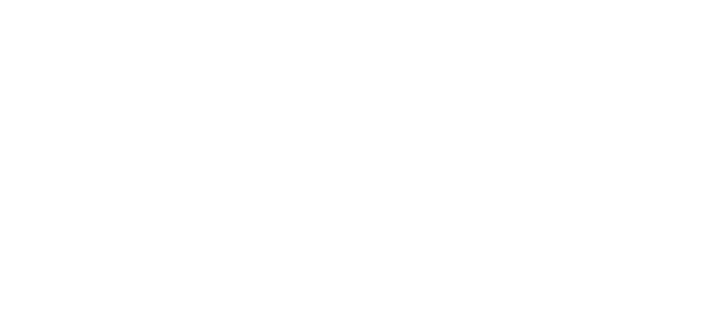
Frontiers in Communication |